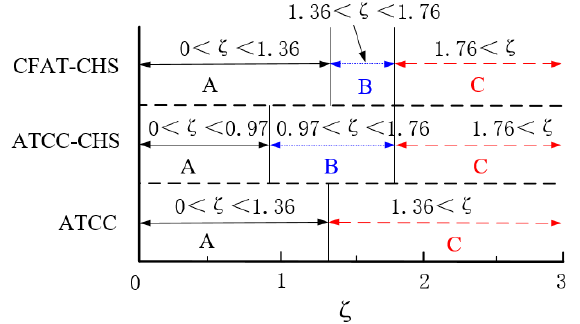
Figure 13. Curve type versus ξ